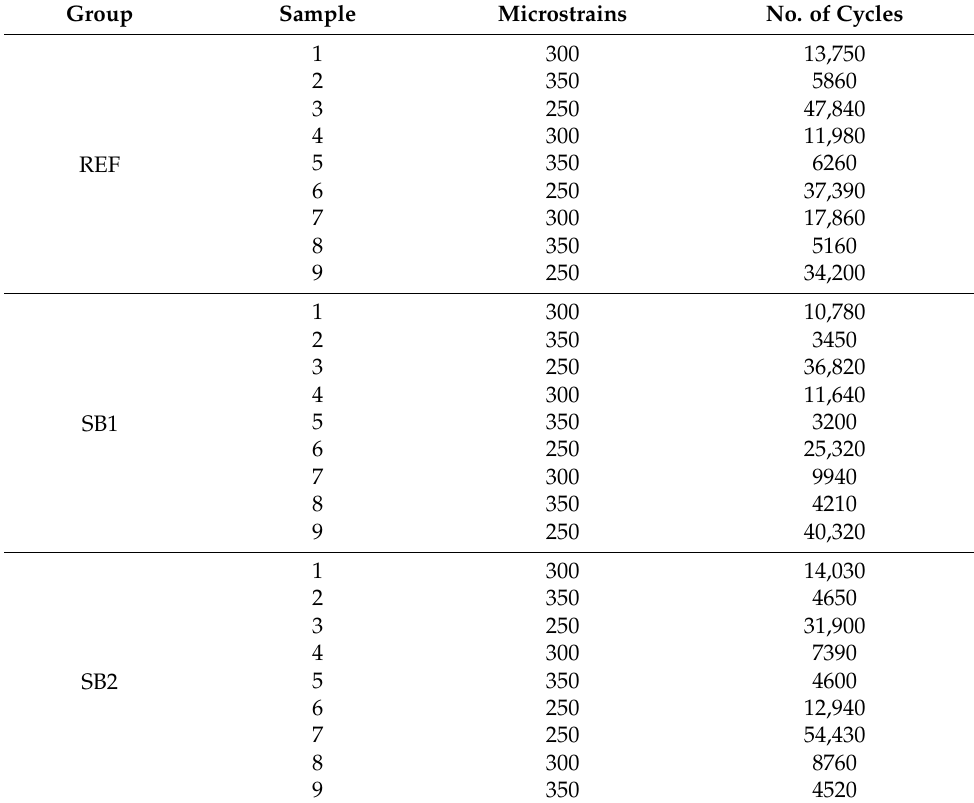
Table 2. Compilation of the results yielded by the uniaxial fatigue